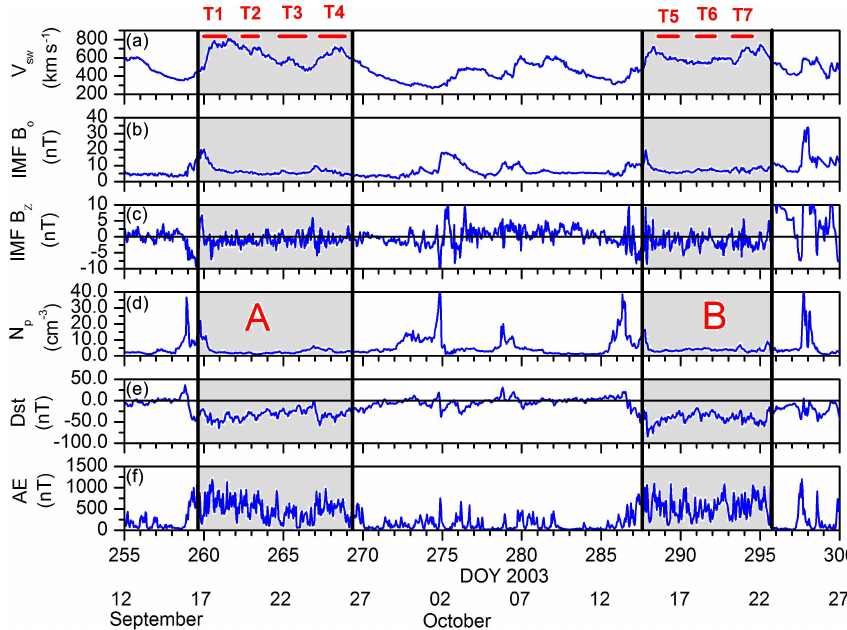
Figure 1. Panels (a) to (b) show ACE solar wind data: speed ( V sw ), IMF magnitude ( B o ), IMF B z component (in GSM) and solar wind proton density ( N p ). Panels (e) and (f) show 1h Dst and 1min AE geomagnetic indices. The interval is DOY 255 to 300 of 2003 (12 September to 27 October 2003). The horizontal red lines marked T1 to T7 indicate the periods corresponding to the Cluster magnetotail crossings studied in this work. Period A is the September HSS interval, and period B is the recurrent event of the September